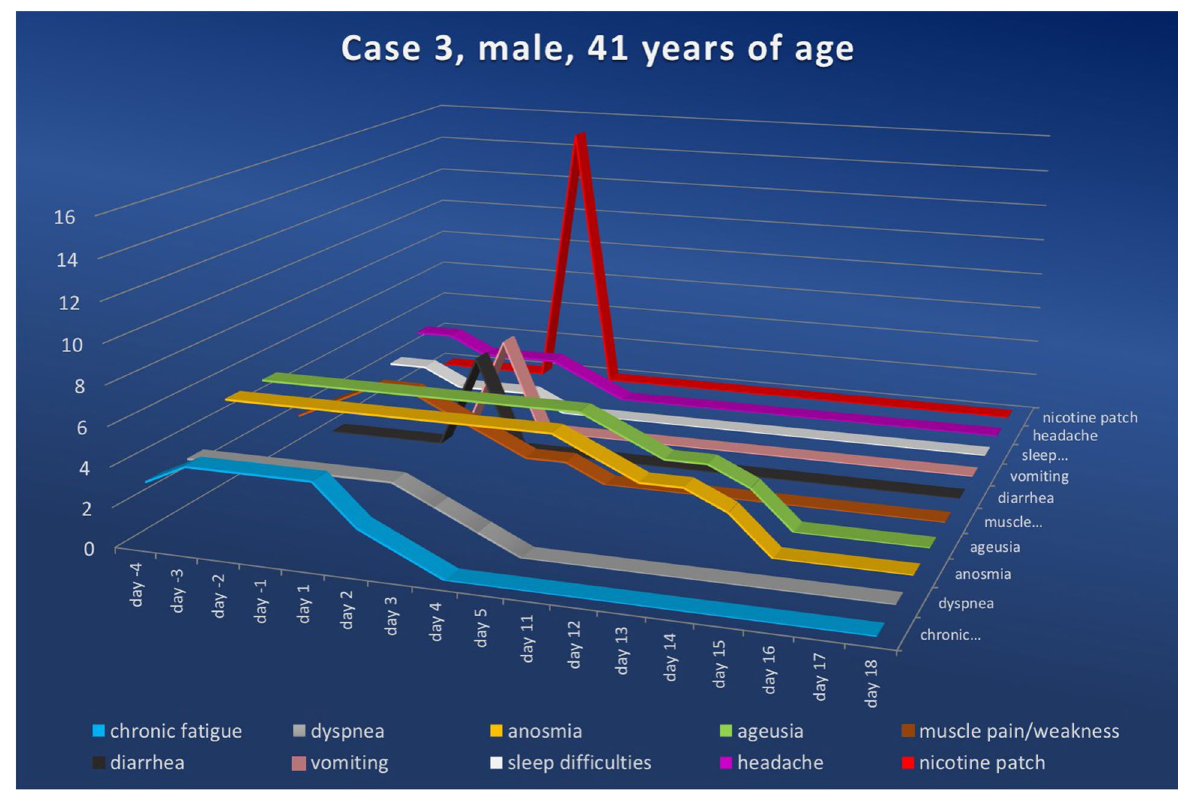
Fig. 5 Symptom score for case 3 ranging from the fourth day prior to and to the eighteenth day after nicotine administration (fourth symptom-free day). Upon nicotine treatment, the symptom scores in all categories fell continuously. Despite the mistaken higher dosage and cessation of nicotine application within ten hours of treatment initiation, total remission was achieved on day sixteen. The numerical value in the ordinate shows the value of the symptom score, while the nicotine dosage for the amount delivered per 24 h is shown in